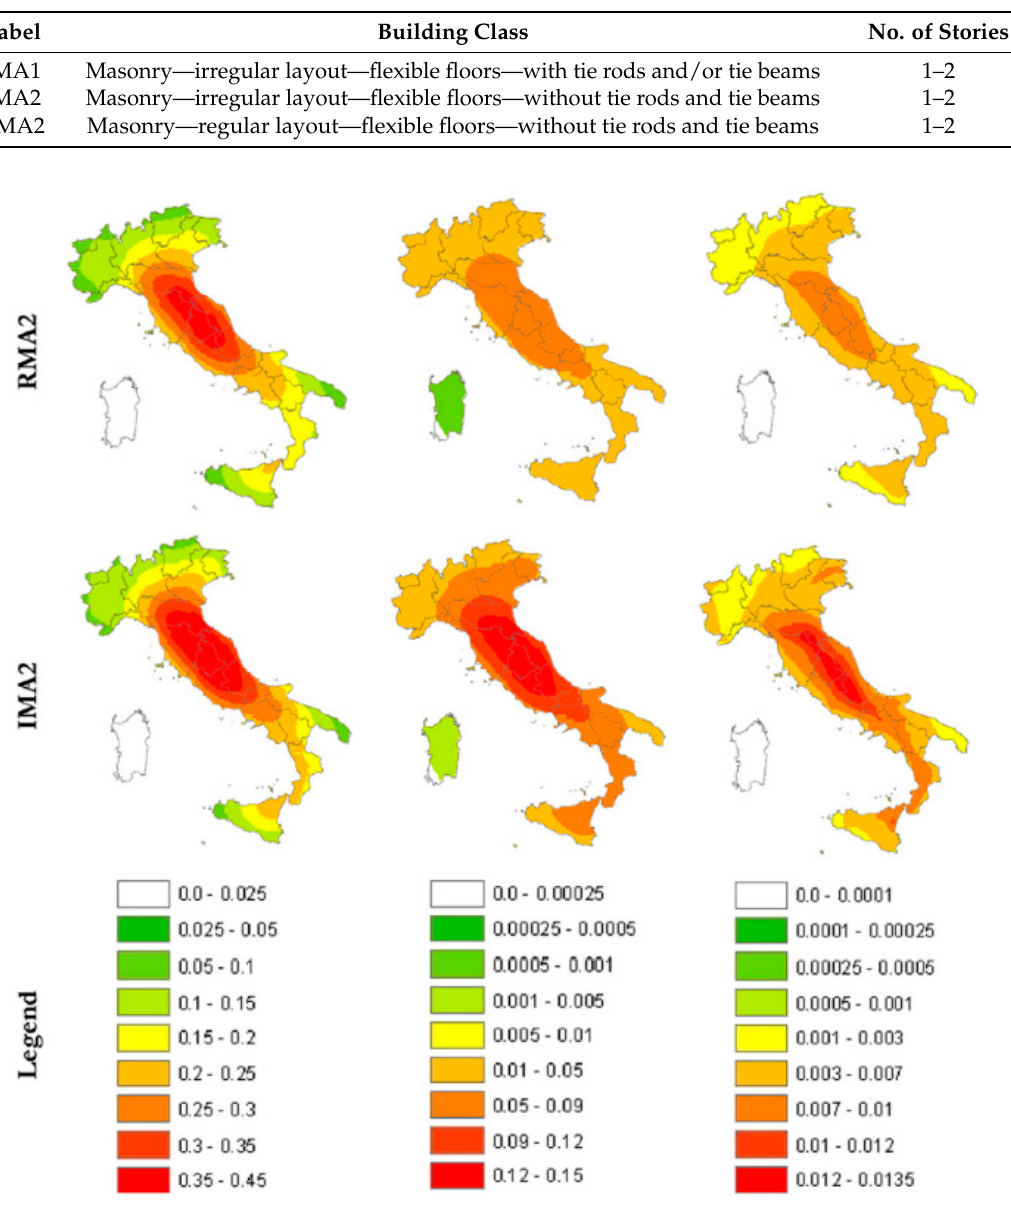
Figure 2. Italian annual probability of exceeding DS1, DS3, and DS5 (in the columns) for the building typologies RMA2 and IMA2 defined in Table 2 (in the rows) [23].